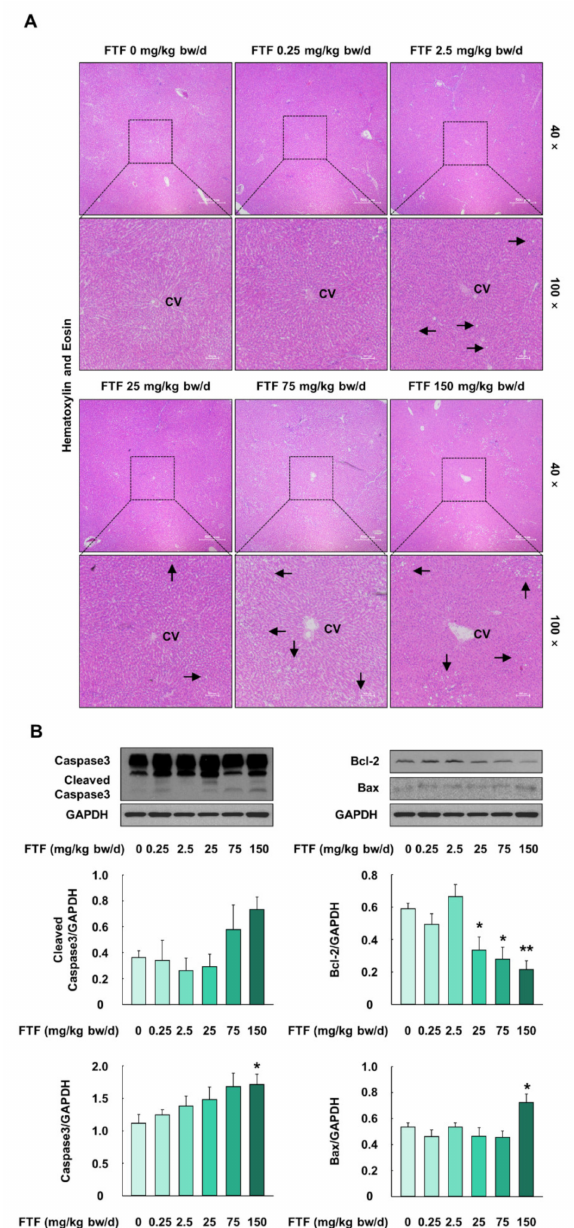
Figure 8. Effects of FTF on histological alterations and apoptosis markers in rat liver: ( A ) hematoxylin and eosin staining of rat liver sections. The magnification of the image was 40 × and 100 × ; ( B ) protein expression of Caspase3, cleaved-Caspase3, Bcl-2, and Bax in female SD rat livers. Black arrows indicate fatty infiltration in rat liver. Rats were administered FTF at 0, 0.25, 2.5, 25, 75, and 150 mg/kg bw/day for 28 days ( n = 3 animals per group). GAPDH was used as the loading control. Images are representative of three independent experiments. The results are expressed as mean ± SEM and statistically significant differences, as compared with the control (corn oil), are indicated as * P < 0.05 and ** P < 0.01. Abbreviations: CV, central vein; Bcl-2, B-cell lymphoma 2; Bax, Bcl-2-associated X protein; SD, Sprague Dawley; FTF, flutriafol; GAPDH, glyceraldehyde 3-phosphate dehydrogenase; SEM, standard error of